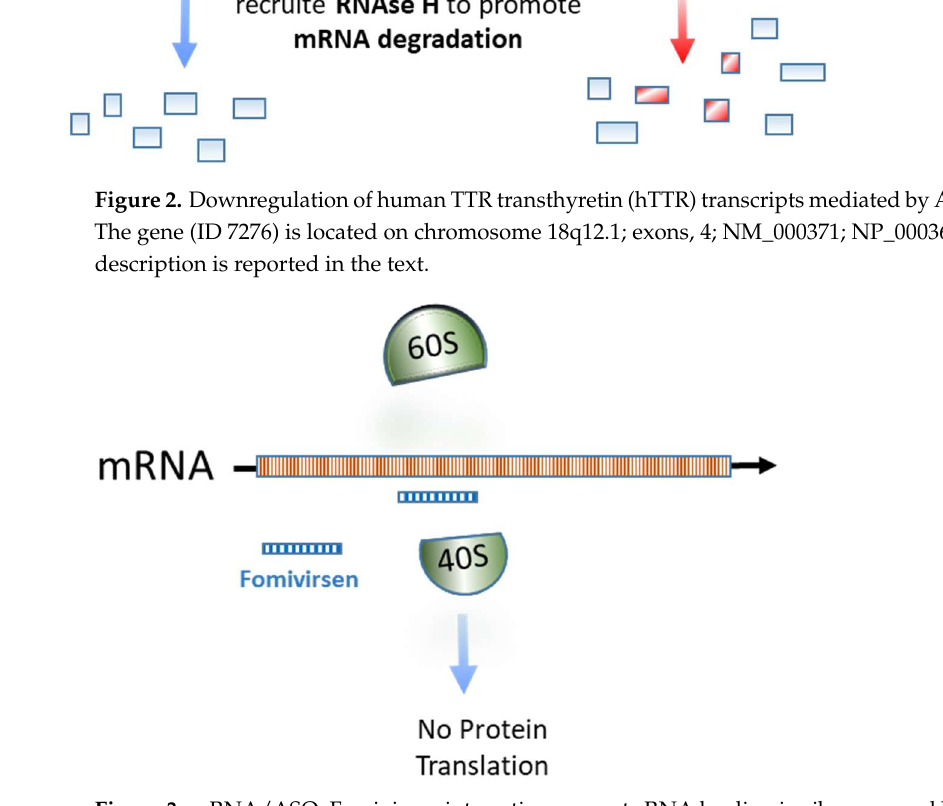
Figure 4. Exon skipping through PMO Eteplirsen to restore Dystrophin (DMD) open reading frame. The gene (ID 1756) is located on Chromosome X. ID; exons, 89; NM_004006; NP_003997. A detailed description is reported in the text.